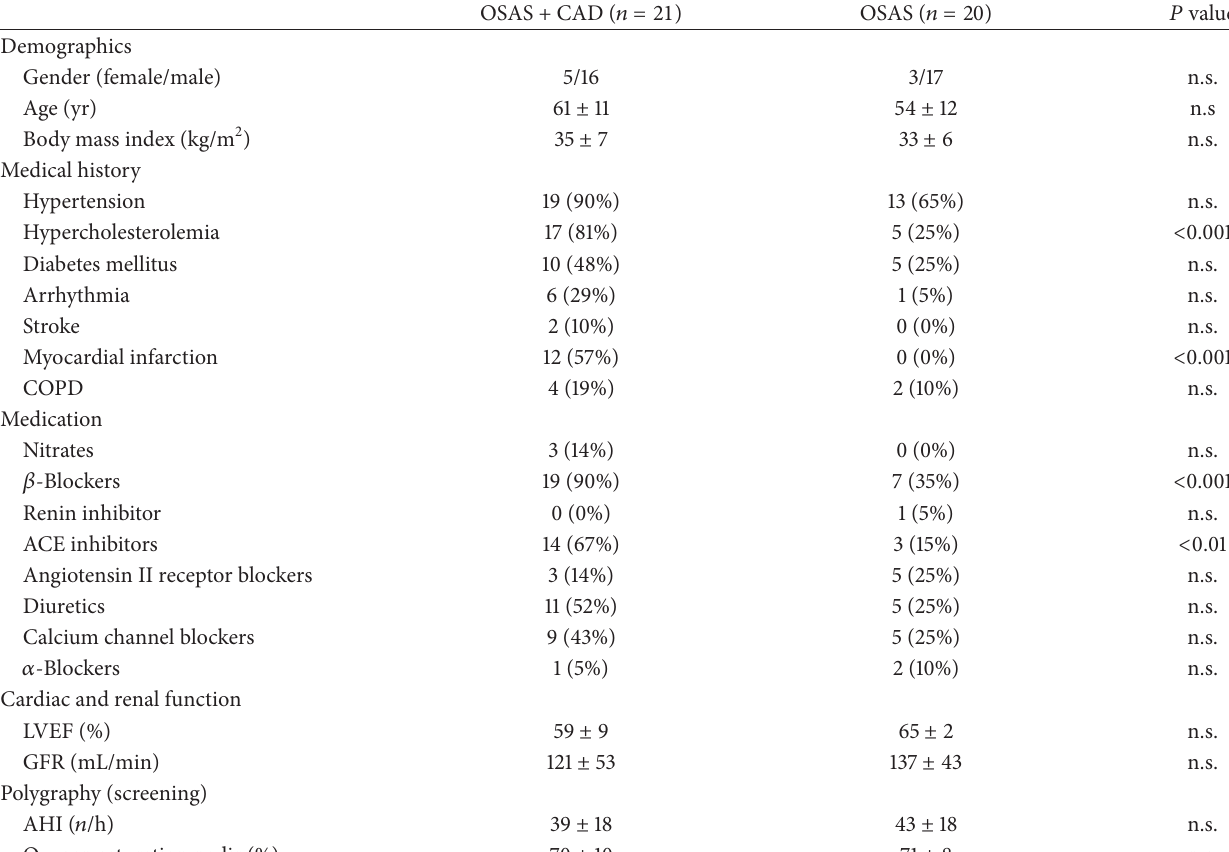
Table 1: Clinical characteristics.